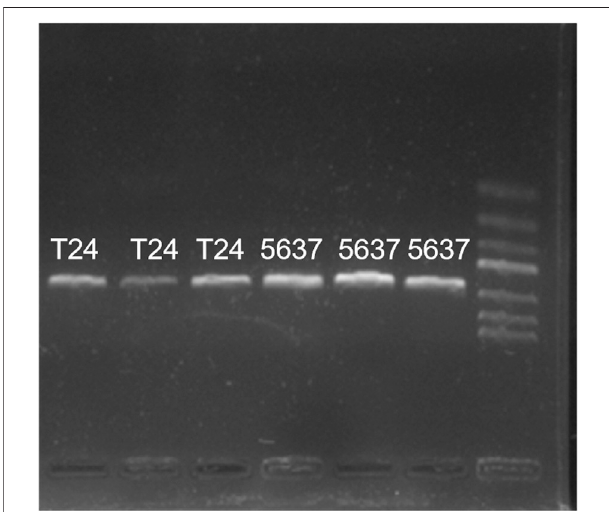
FIGURE 2 | General PCR results of cell lines T24 and 5,637 cDNA. PCR bands were observed in both cell lines T24 and 5,637, while the band brightness of the three groups of 5,637 was lighter than that of T24.